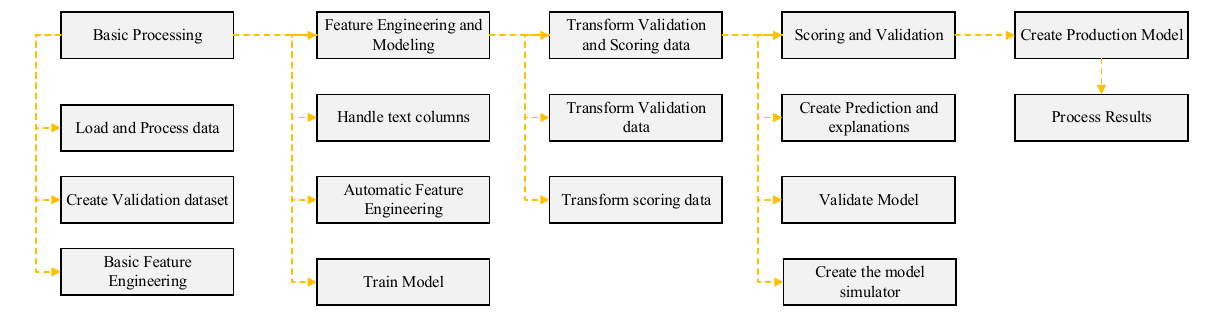
Figure 8. Flow diagram depicting GBT modeling.